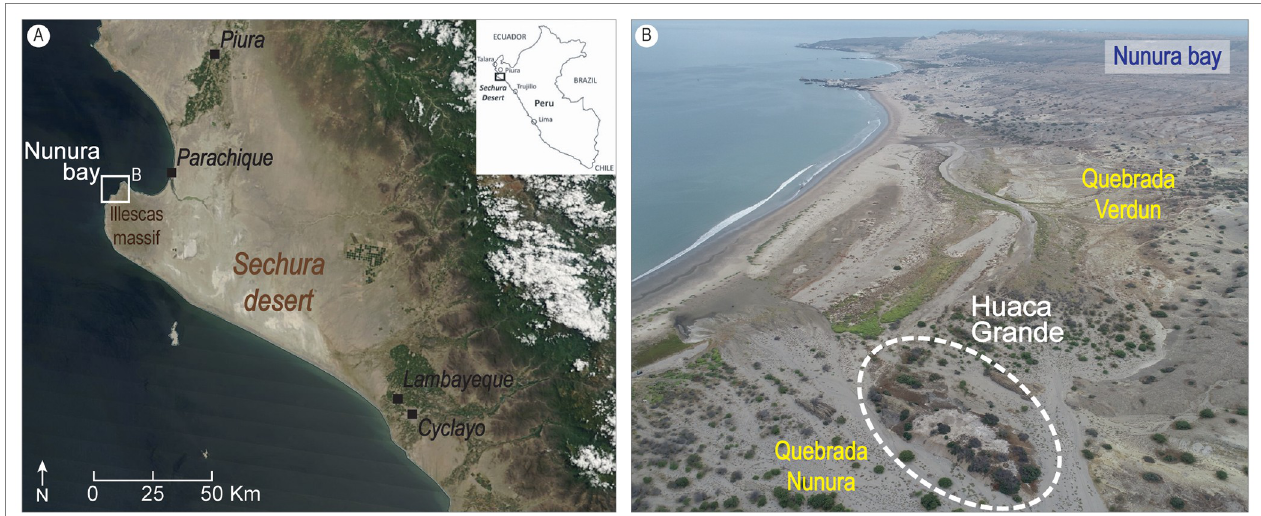
Fig 1. Location of the Huaca Grande archaeological site. A. Location of Nunura Bay and the Illescas massif within the Sechura Desert (satellite photo from NASA Worldview, https://worldview.earthdata.nasa.gov, annotated by the authors). B. Aerial view of Nunura Bay and the Huaca Grande mound (dashed line), showing the location of the two gullies ( quebradas ) near the